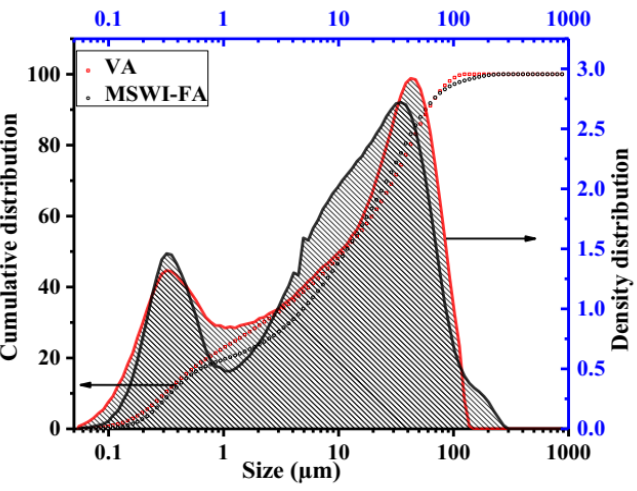
Figure 3. Particle size and density distribution of MSWI-FA and VA.